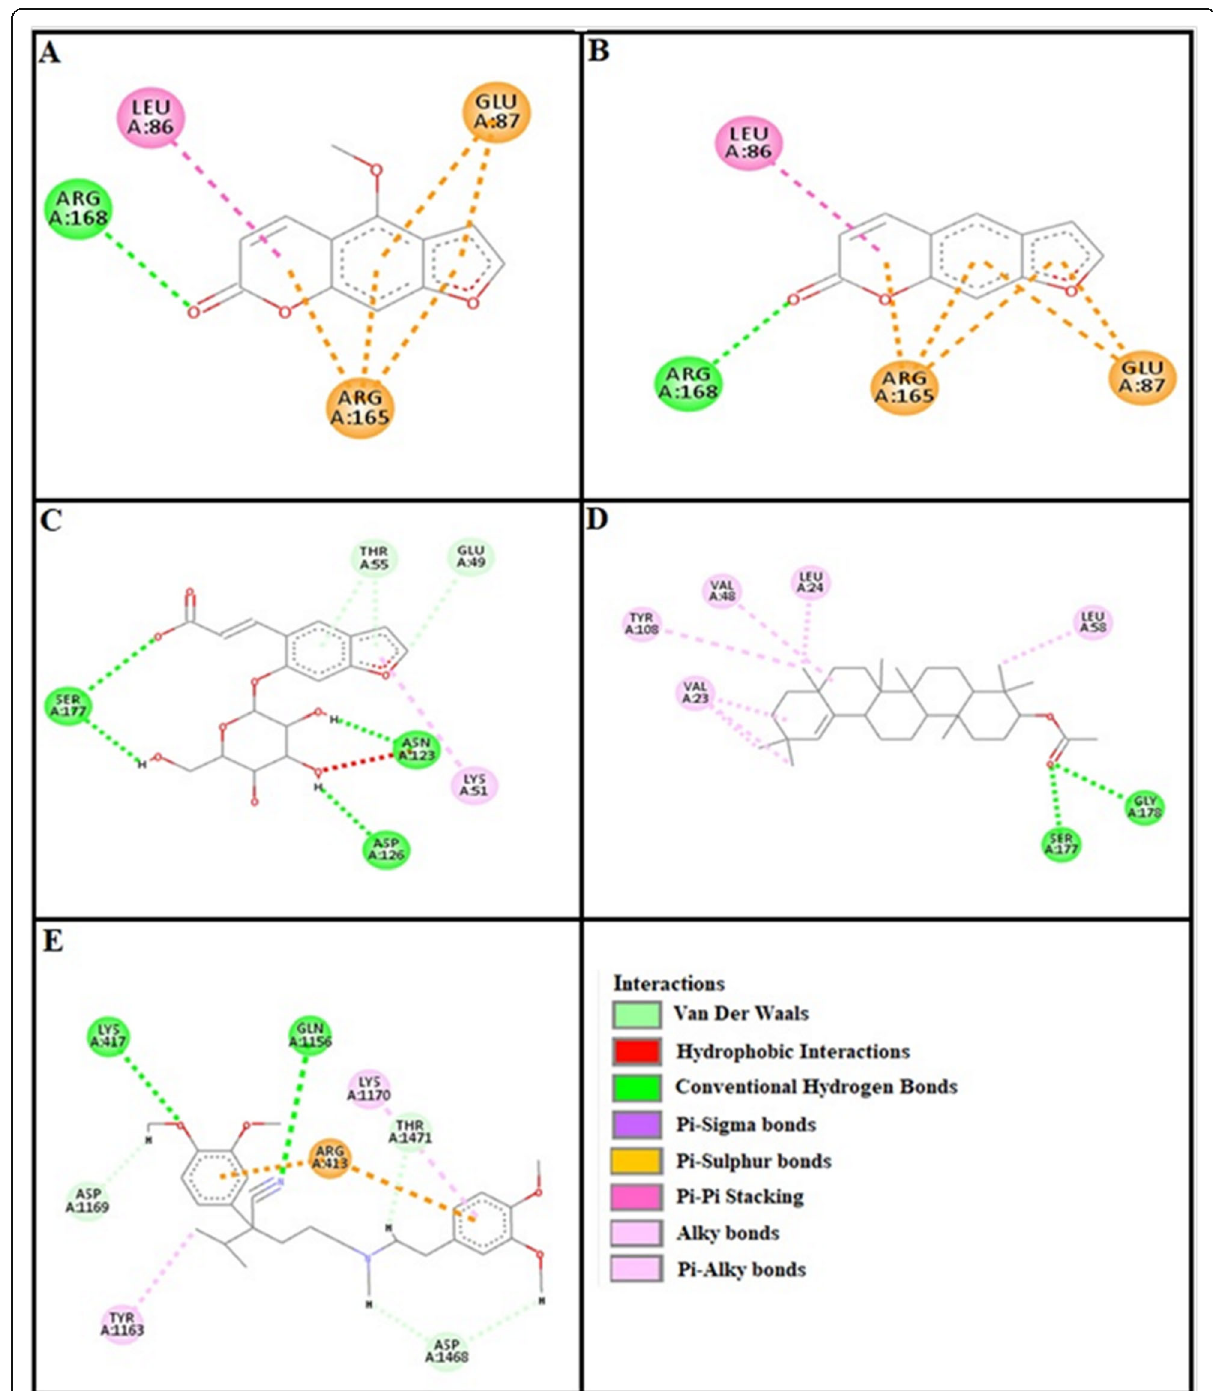
Fig. 11 a , b , c , d and ( e ) represents interactions of bergapten, psoralene, psoralenoside, germanicol acetate and verapamil against target: voltage gated L-Type calcium channels respectively, evaluated through Biovia Discovery Studio